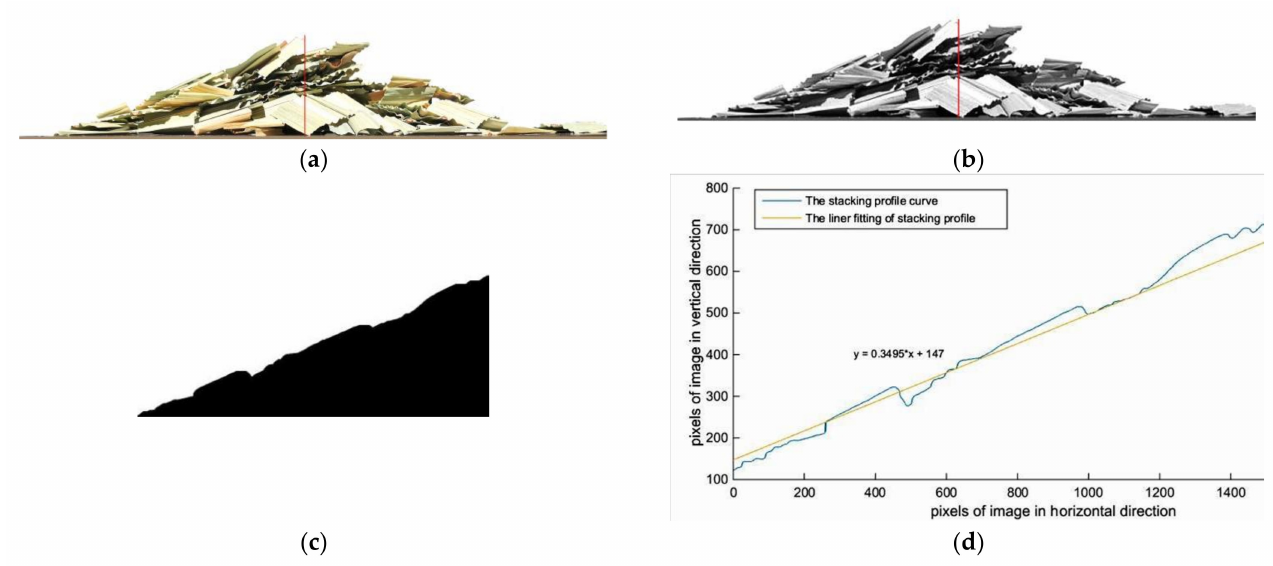
Figure 2. Contour curve extraction process: ( a ) original stacking image, ( b ) gray processing, ( c ) the left stacking image, ( d ) linear fitting of bulk stacking